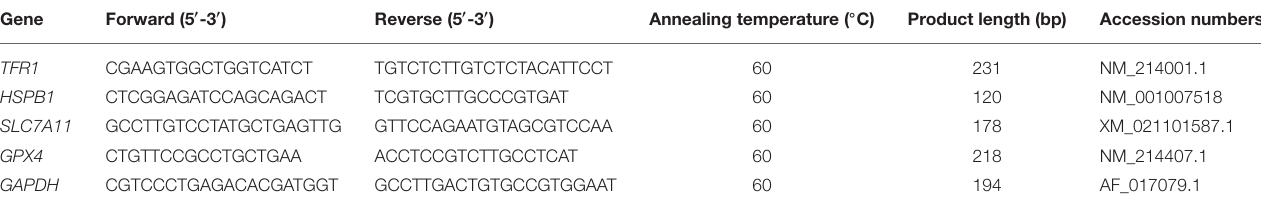
TABLE 1 | Primer sequences used for real-time PCR.